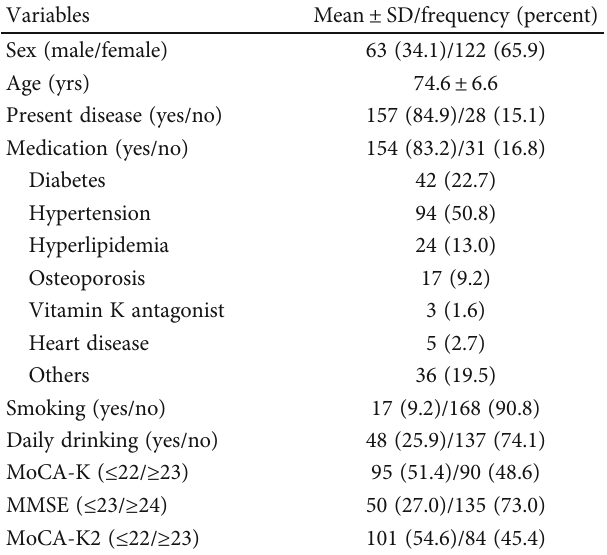
Table 2: Common characteristics of the participants ( N = 185 ).